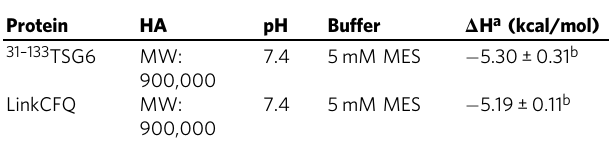
Table 1 Thermodynamic parameters of interaction between LinkCFQ and